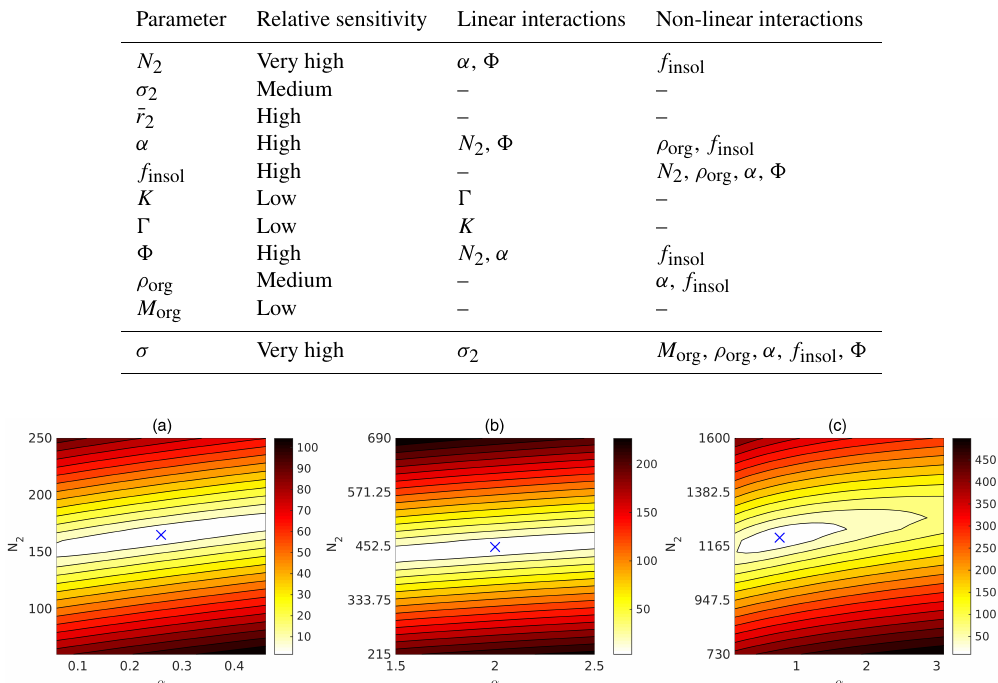
Table 3. Summary of qualitative sensitivities and parameter interactions observed in response surfaces for all parameters used in the complete partitioning scheme a p w σ nf for the marine environment. The surface tension σ for classical Köhler theory a np w σ f is also included at the bottom of the table.